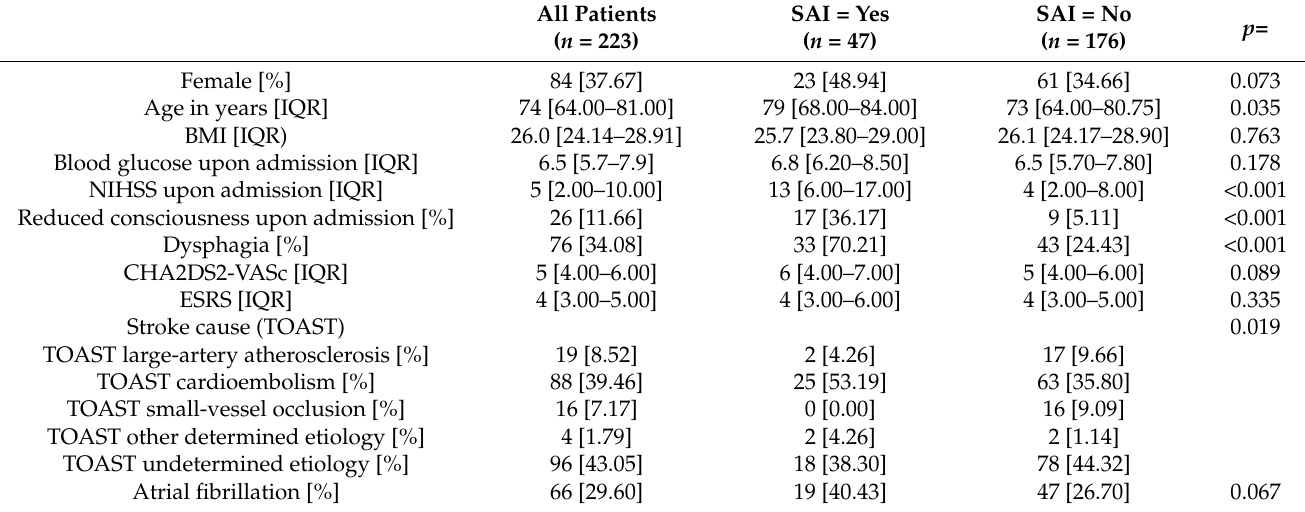
Table 1. Distribution of the Clinical Characteristics According to SAI